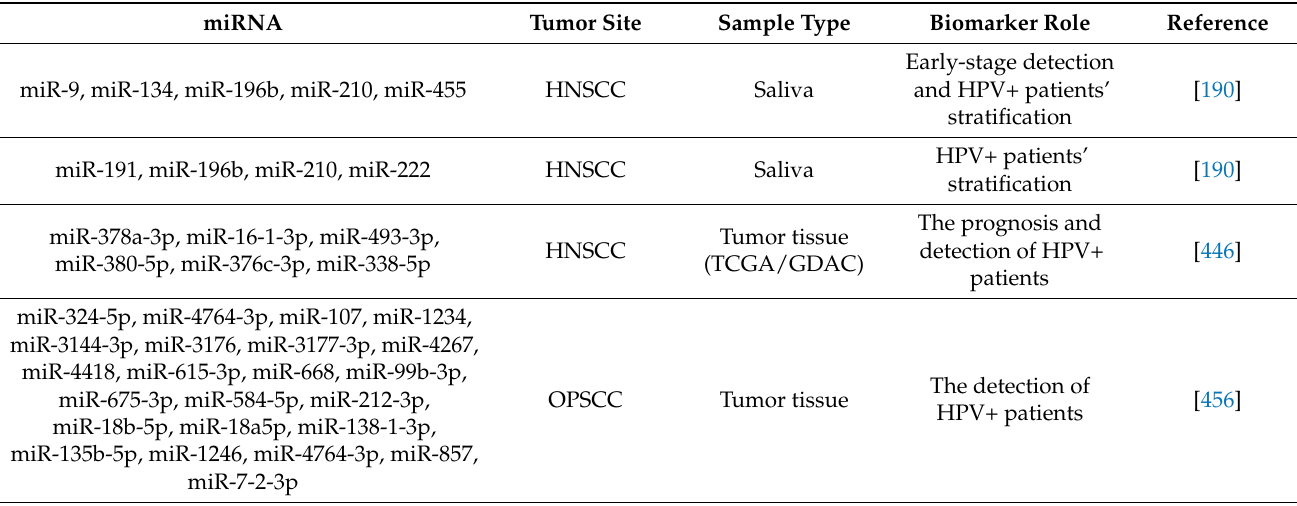
Table 5. Summary of the most common miRNA signatures associated with HPV infection in HN- SCC